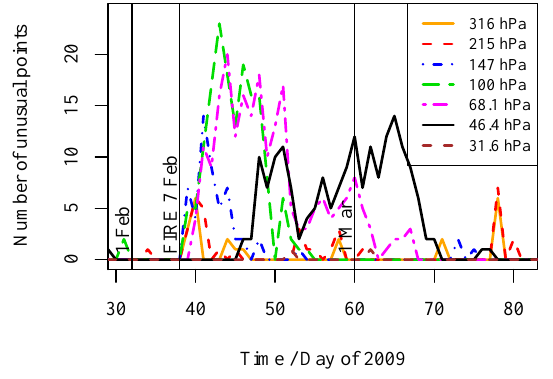
Fig. 3. Number of points for each day for which the CO mix- ing ratio was identified as unusual (as defined in the text) in the 5 ◦ S–60 ◦ S latitude range.